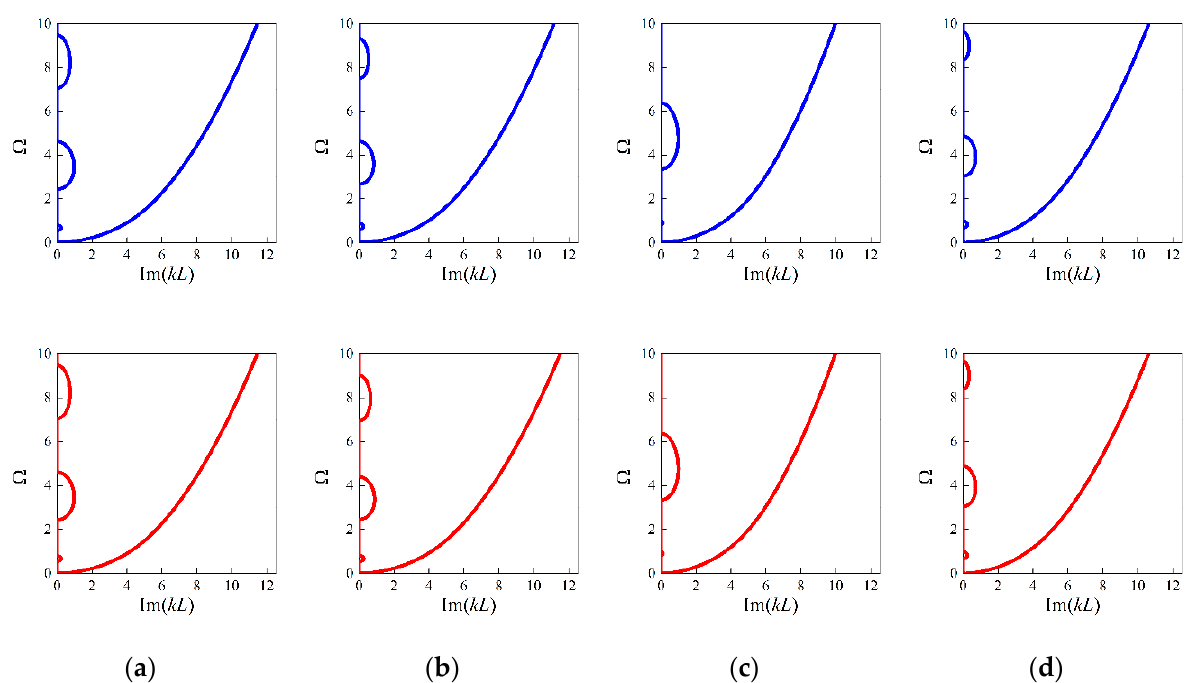
Figure 15. The imaginary panels of flexural waves of the random samples based on the generated structures and real structures with L = 0.01 m: ( a ) example 1; ( b ) example 2; ( c ) example 3; ( d ) example 4. The blue lines denote the results based on generated values and the red lines denote that of ground truth.